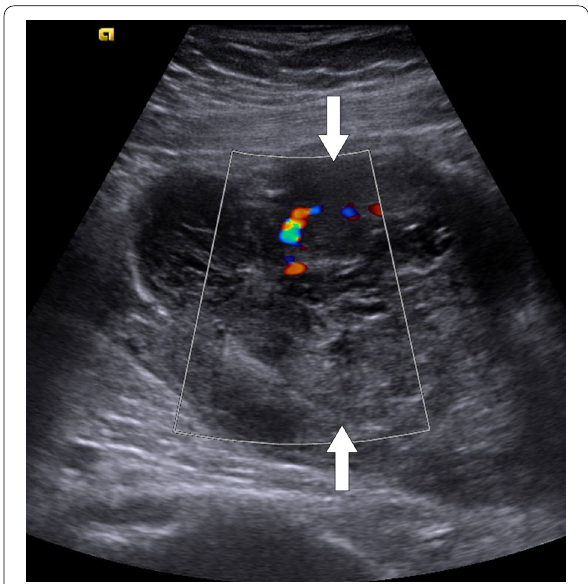
Fig. 32 Tubal ectopic pregnancy. A 24-year-old female with abdominal pain. Gray scale transabdominal US shows a complex-appearing, mostly solid left adnexal mass with mild internal vascularization on color Doppler US examination (arrows). Serum beta-hCG level was found to be mildly elevated (1120 mIU/mL). Imaging findings suggestive of ectopic pregnancy and she was placed on methotrexate treatment. Serial follow-up US exams did not demonstrate any decrease in size and her serum beta-hCG level remained persistently elevated between 1000 and 2000 mIU/mL. The lack of response to medical treatment prompted surgical removal of the mass which finally confirmed ectopic pregnancy with no histopathological evidence of neoplastic or inflammatory